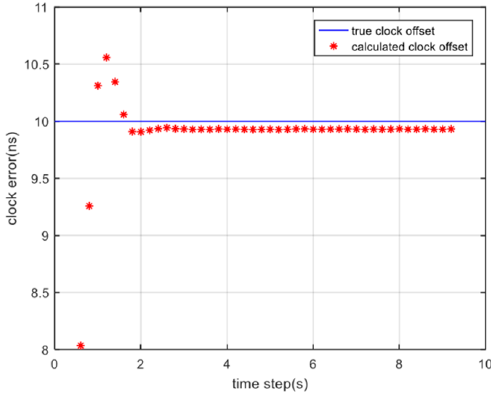
Figure 12. Clock offset between the two satellites. Figure 12. Clock o ff set between the two